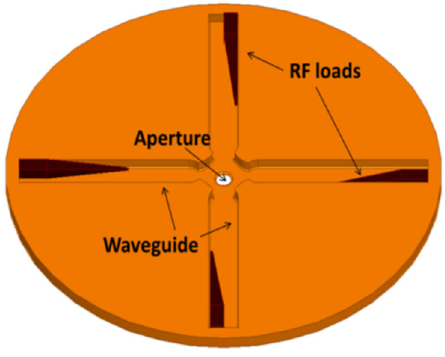
FIG. 1. One cell of waveguide damped